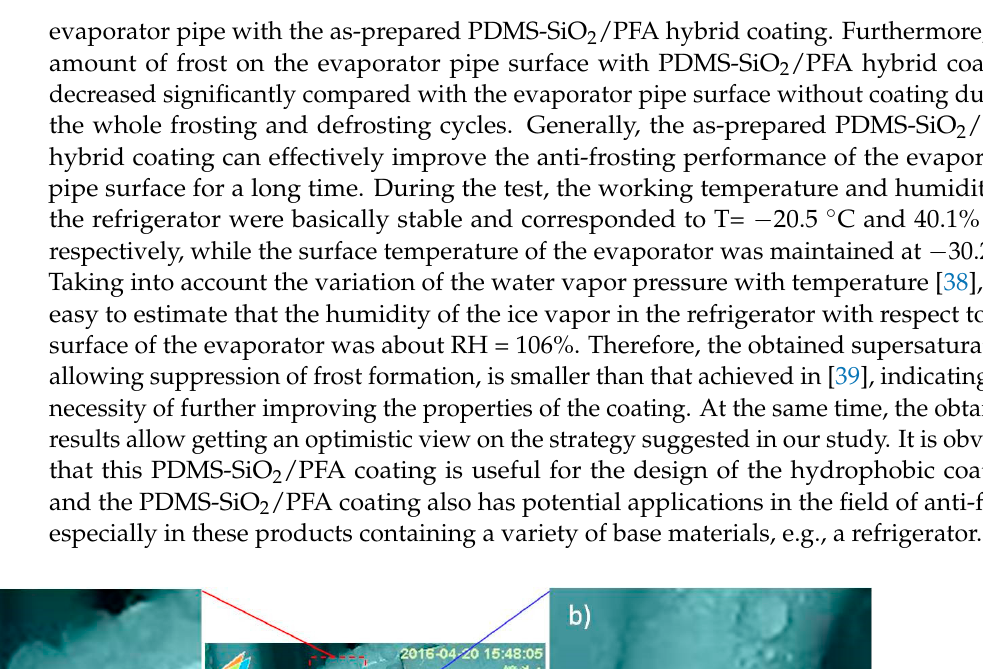
Coatings 2021 , 11 , 256